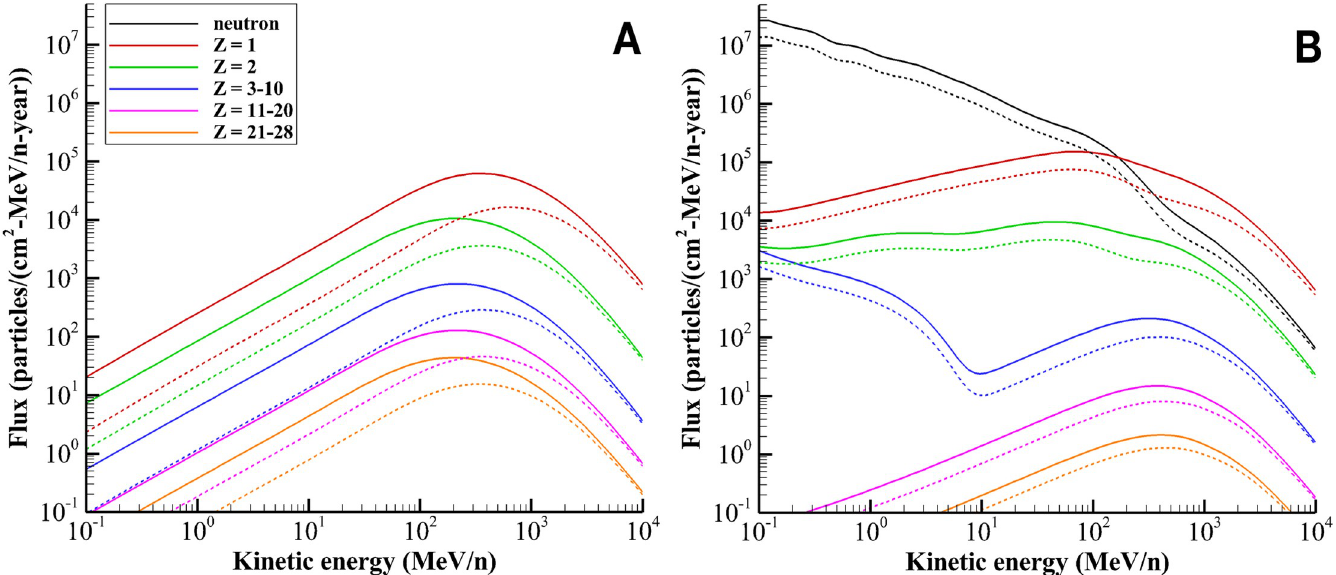
Fig 3. GCR particle spectra at solar minimum conditions (June 1976) denoted by solid lines and solar maximum conditions (June 2001) denoted by dashed lines in (A) free space and (B) behind 20 g/cm 2 of aluminum to female BFOs as described by the Badhwar–O’Neill 2010 GCR model [14], HZETRN transport code [13,16,17],and human phantoms [15,18,19]. Plot data available in S1 Data. BFO, blood-forming organ; GCR, galactic cosmic radiation; HZETRN, High Charge and Energy Transport.